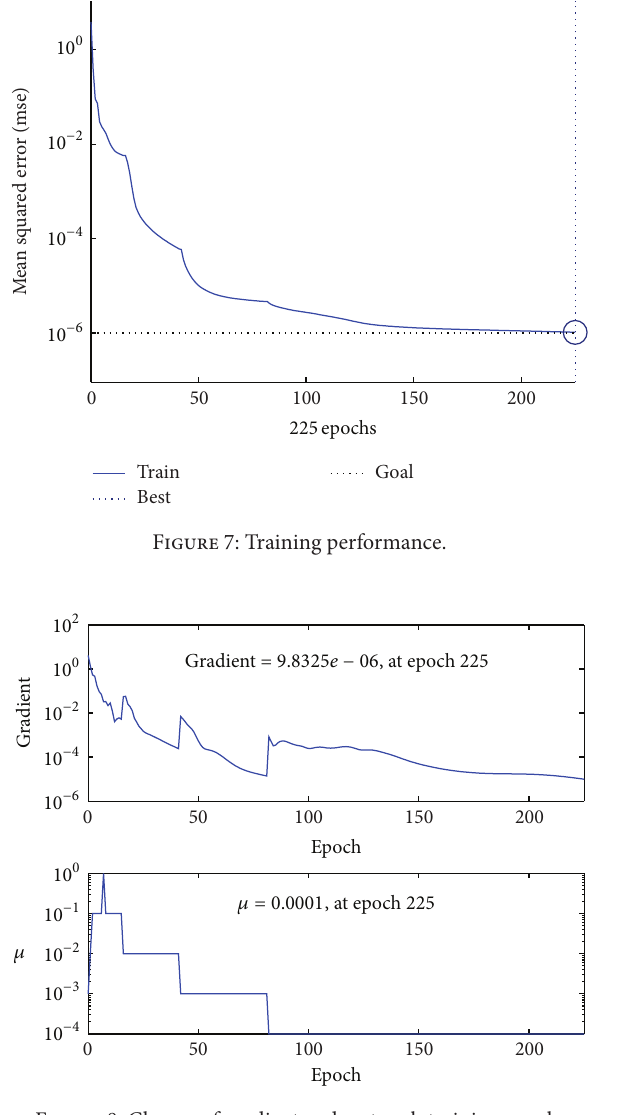
Figure 8: Change of gradient and 𝜇 at each training epoch.